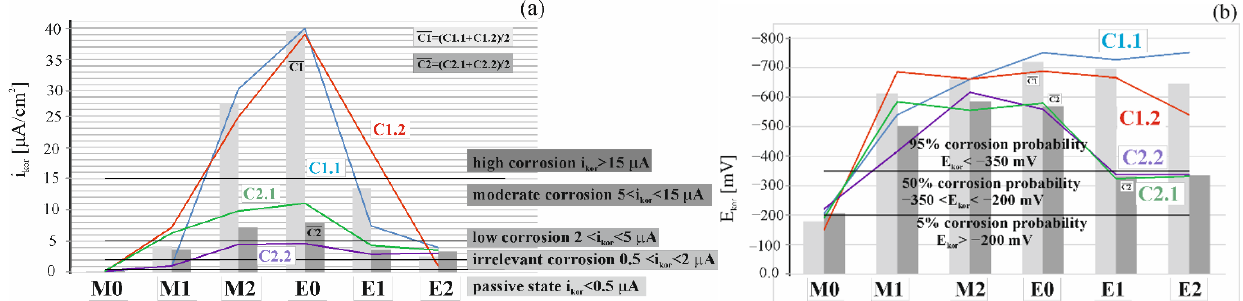
Figure 5. Potentiodynamic polarization curves for steel reinforcement in concrete C2 obtained for selected specimens: ( a ) C2.1 and ( b ) C2.2; M0 before chloride migration, M1 after 7 days, M2 after 14 days of chloride migration and E0 after 21 days of chloride migration and E1 after 10 days, E2 after 21 days of chloride extraction.